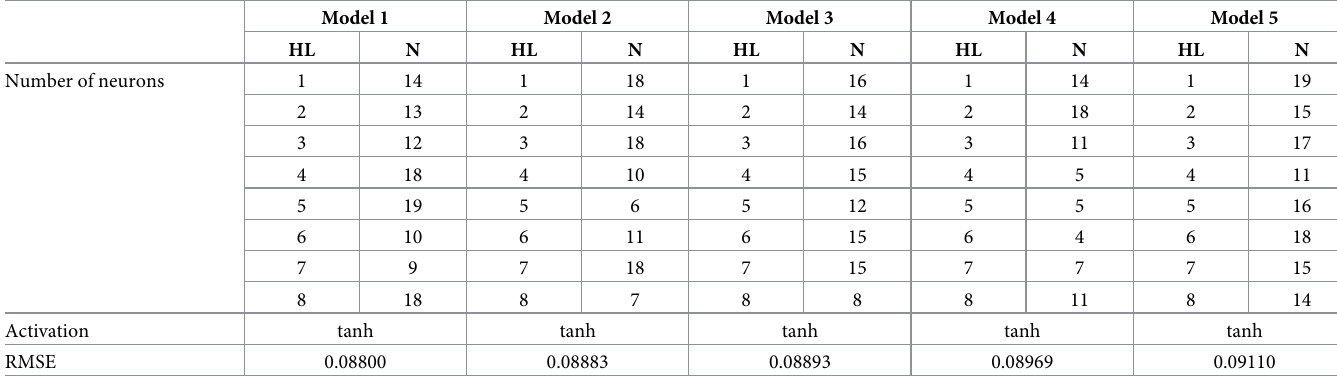
Table 15. Hyperparameter search results summary (Run 8). Top 5 Models out of 250 candidate models from Run 8.